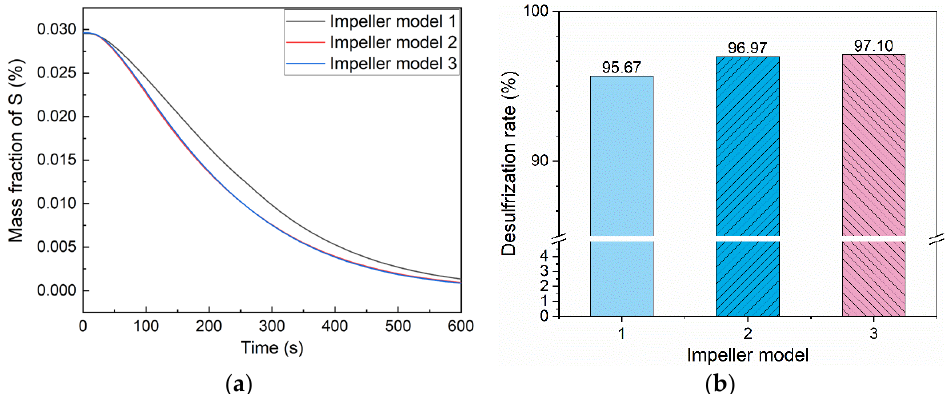
Figure 3. Desulfurization efficiency. ( a ) The evolution of average sulfur content with time; ( b ) Desul- furization rate at 600 s.